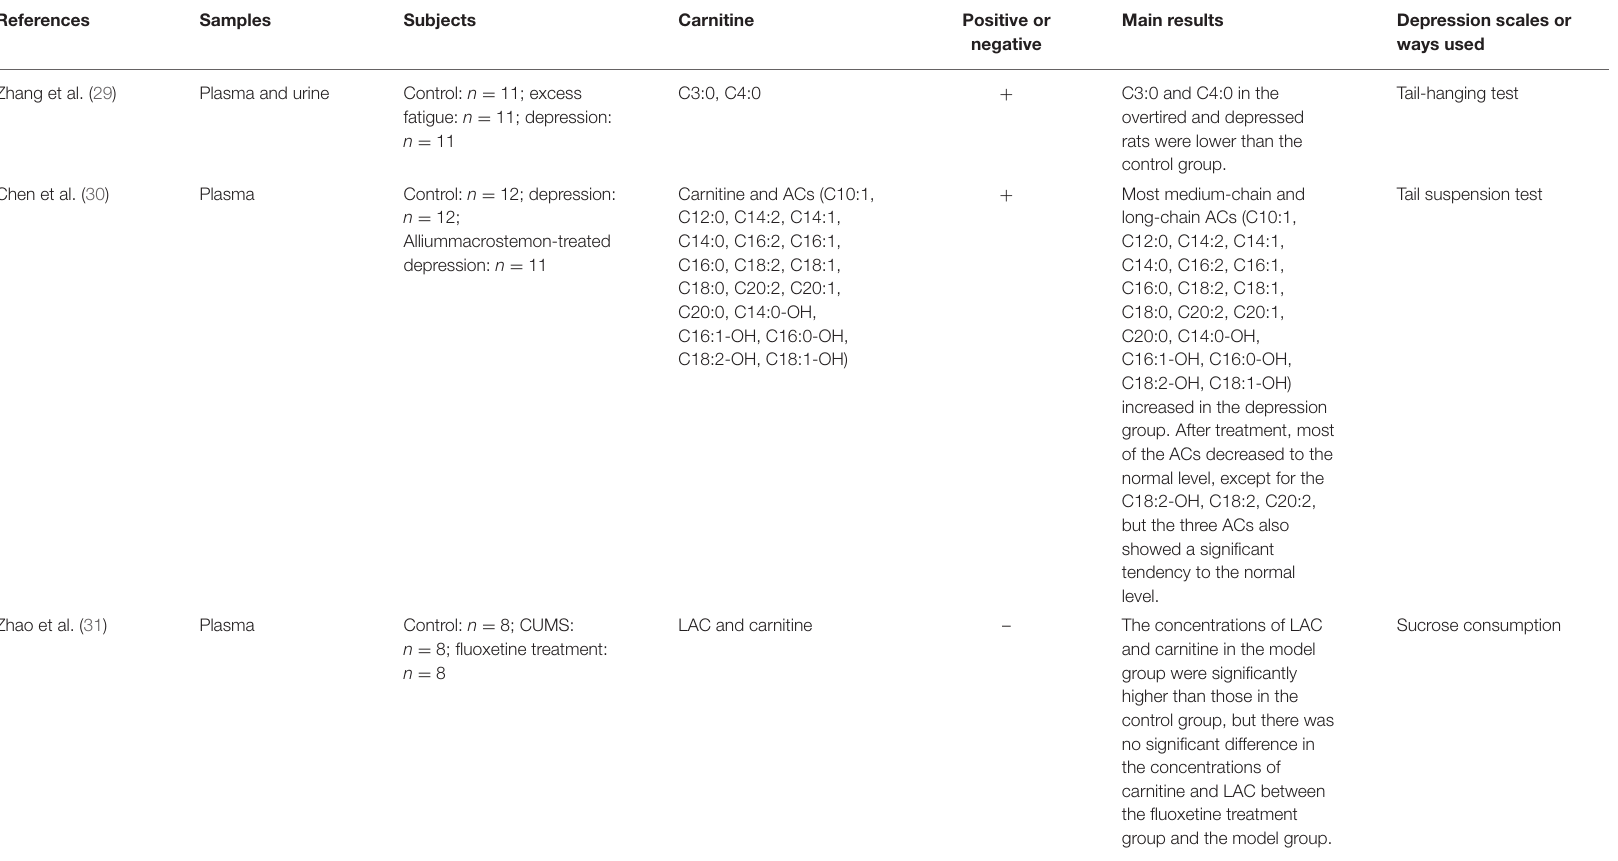
TABLE 1 | Main information of pre-clinical researches studying the correlation between carnitine level and depression in